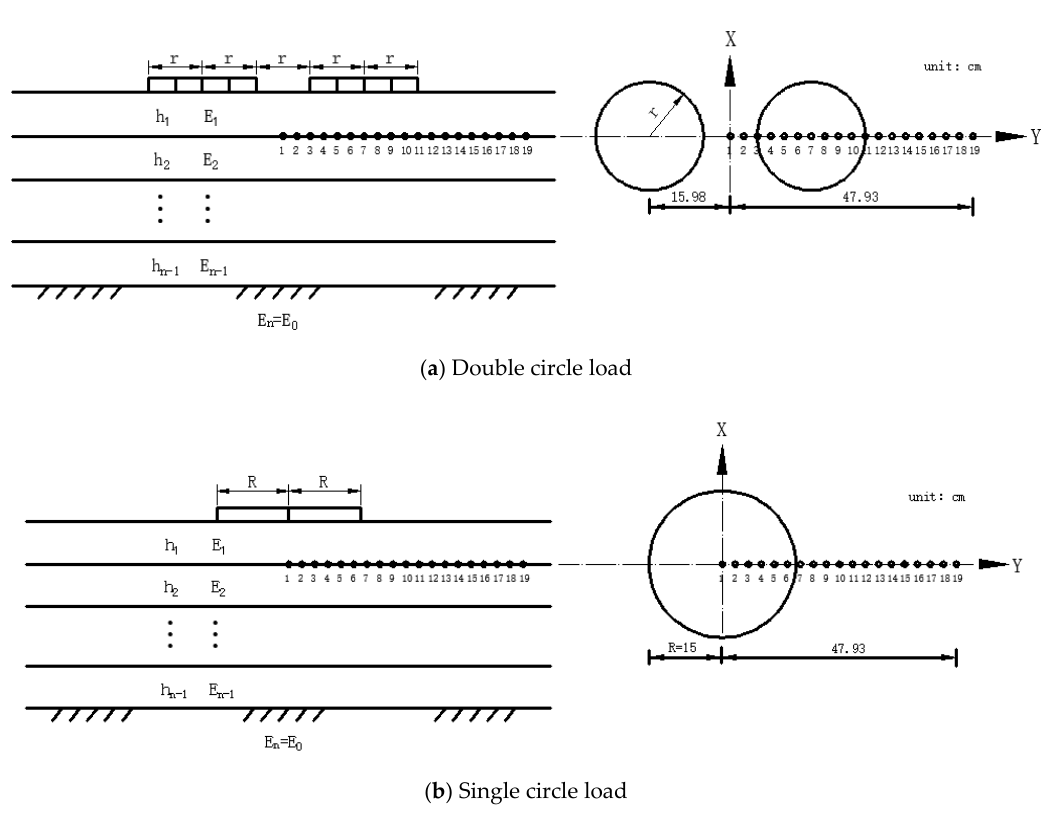
Figure 1. Simplified model of pavement structures and the selected calculation points.